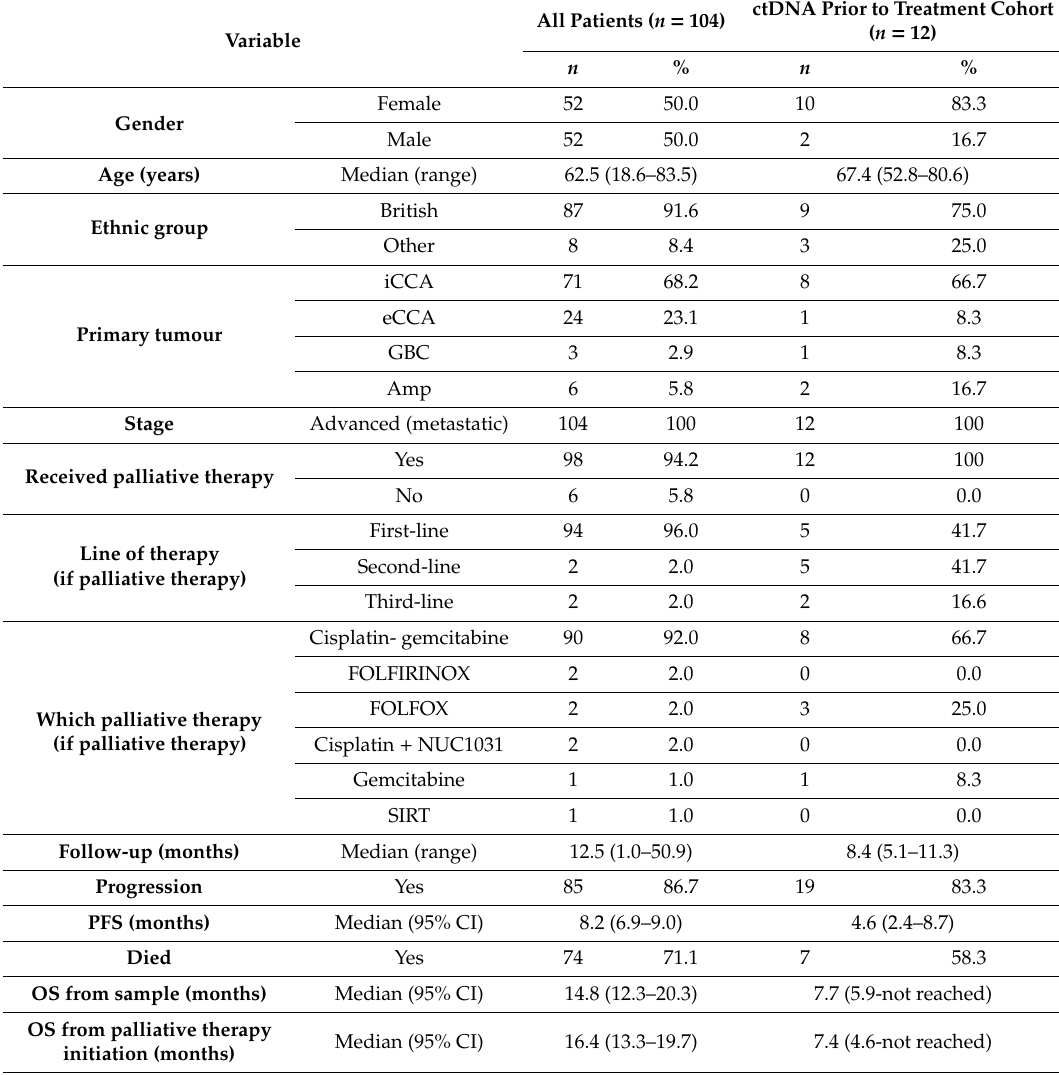
Table 1. Summary of baseline patient